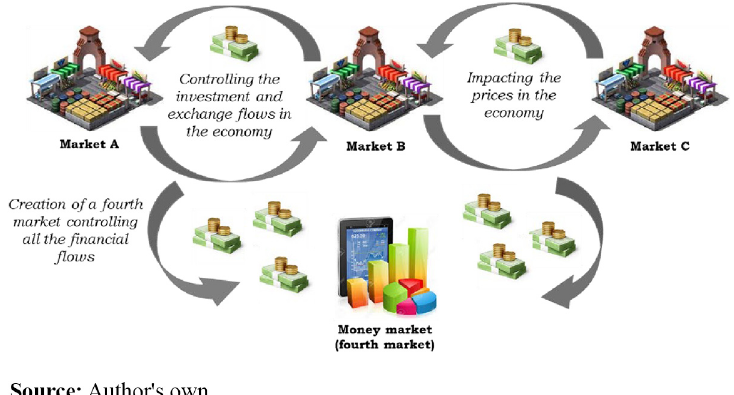
Figure 4. Scenario 3 – a rib (cid:1) a based